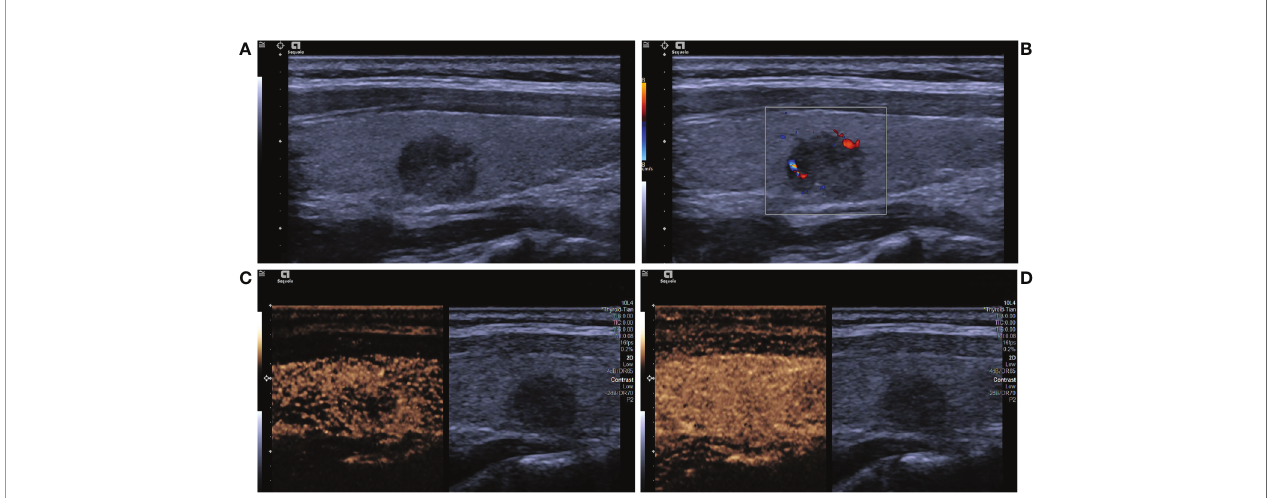
FIGURE 2 | A papillary thyroid carcinoma in a 25-year-old girl. (A) Greyscale ultrasound showed that there was a solid hypoechoic nodule in the right lobe of the thyroid, with irregular margin, wider-than-tall shape, and punctate echogenic foci. The nodule was ACR TI-RADS category 5. (B) Color Doppler showed peripheral vascularity. (C) Contrast-enhanced ultrasound revealed the trend that contrast agent enters the nodule from the periphery to the center (centripetal enhancement) at the time of the 14th second after the injection of contrast agent. (D) Contrast-enhanced ultrasound revealed iso-enhancement at peak (the 22th second after the injection of contrast agent), with ill-de fi ned enhanced border and absence of a regular enhanced ring.